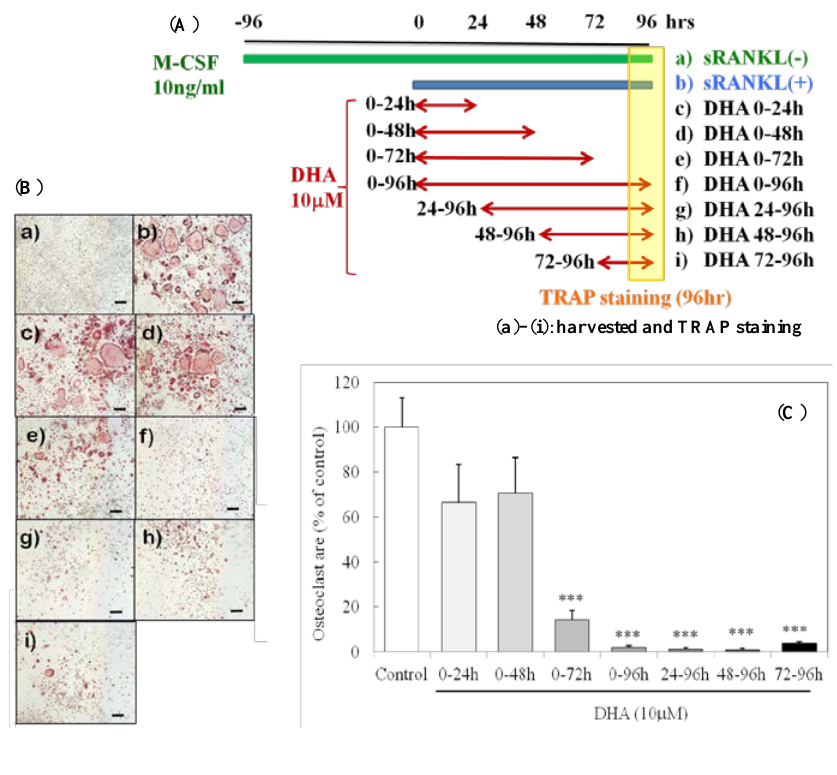
Figure 1. DHA inhibited sRANKL-induced osteoclast differentiation at the late stage. ( A ) Culture conditions and ( B ) representative images of osteoclasts (TRAP staining ( a )–( i )). The scale bar indicates 200 μm. ( C ) The areas occupied by osteoclasts (TRAP + cells with three or more nuclei) were analyzed. Each column and bar represents the mean ± SE of four to five wells. *** Significantly different from the control (sRANKL(+)); p < 0.0001 by Dunnett’s multiple comparison